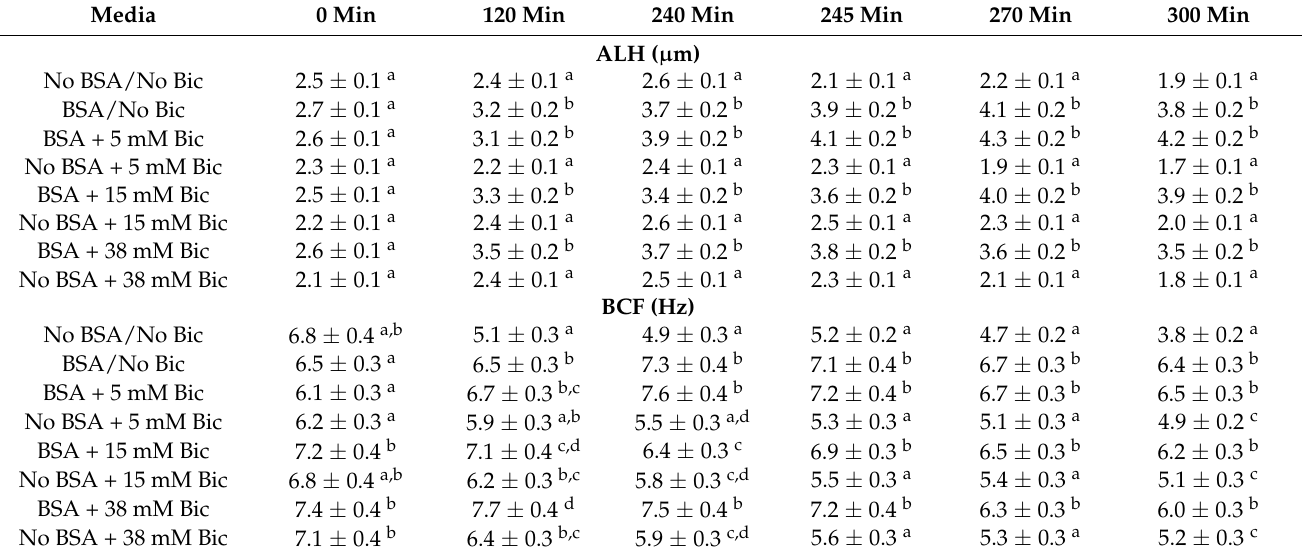
Table 3. Amplitude of lateral head displacement (ALH) and frequency of head displacement (BCF) following incubation of pig sperm with different concentrations of bicarbonate (Bic; 0 mM, 5 mM, 15 mM, 38 mM) and BSA (0, 5 mg/mL) for 300 min. Progesterone (10 µ g/mL) was added at 240 min to induce acrosome exocytosis. Different superscripts (a–d) indicate significant differences ( p < 0.05) between treatments (rows) within the same time point. Data are shown as mean ± SEM for 12 independent